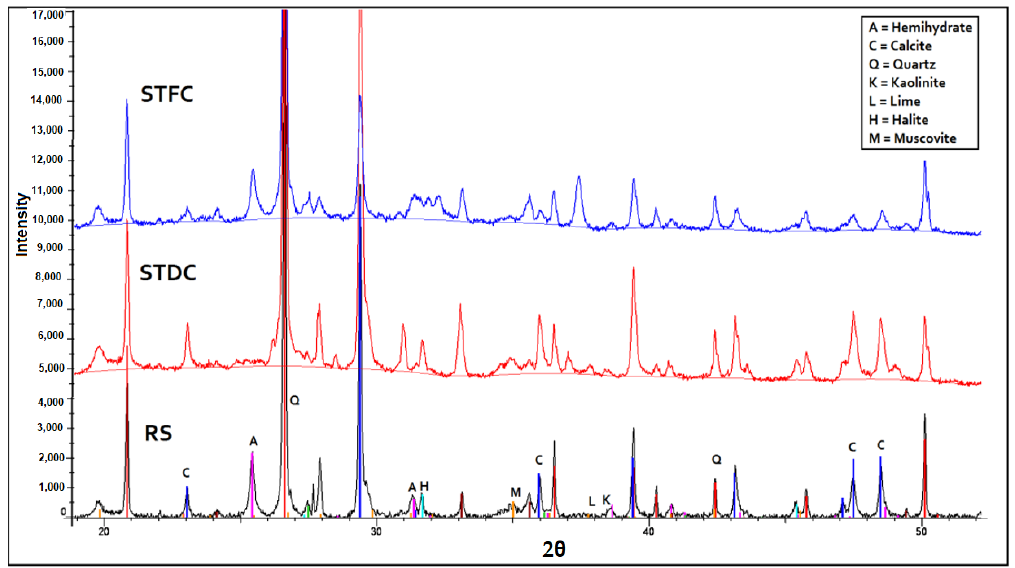
Figure 6. XRD analysis of RS, STDC, and STFC.